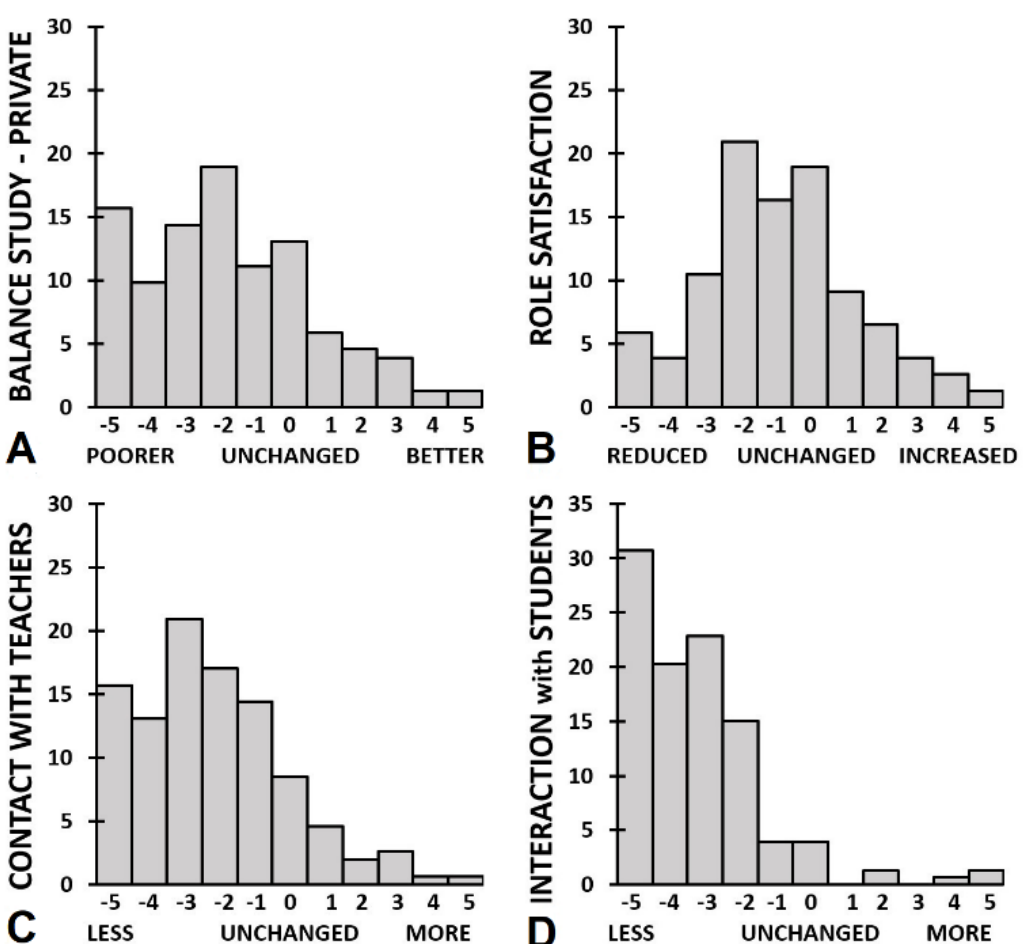
Figure 5. The impact of the COVID-19 pandemic on academic interactions. The distribution of percentages endorsement are shown for, and ( A ) balance study-private life, ( B ) role satisfaction, ( C ) contact with teachers, and ( D ) interactions with students. Table 3. Academic functioning during the COVID-19 pandemic according to sex.